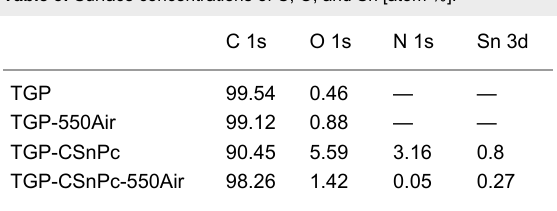
Table 3: Surface concentrations of C, O, and Sn [atom